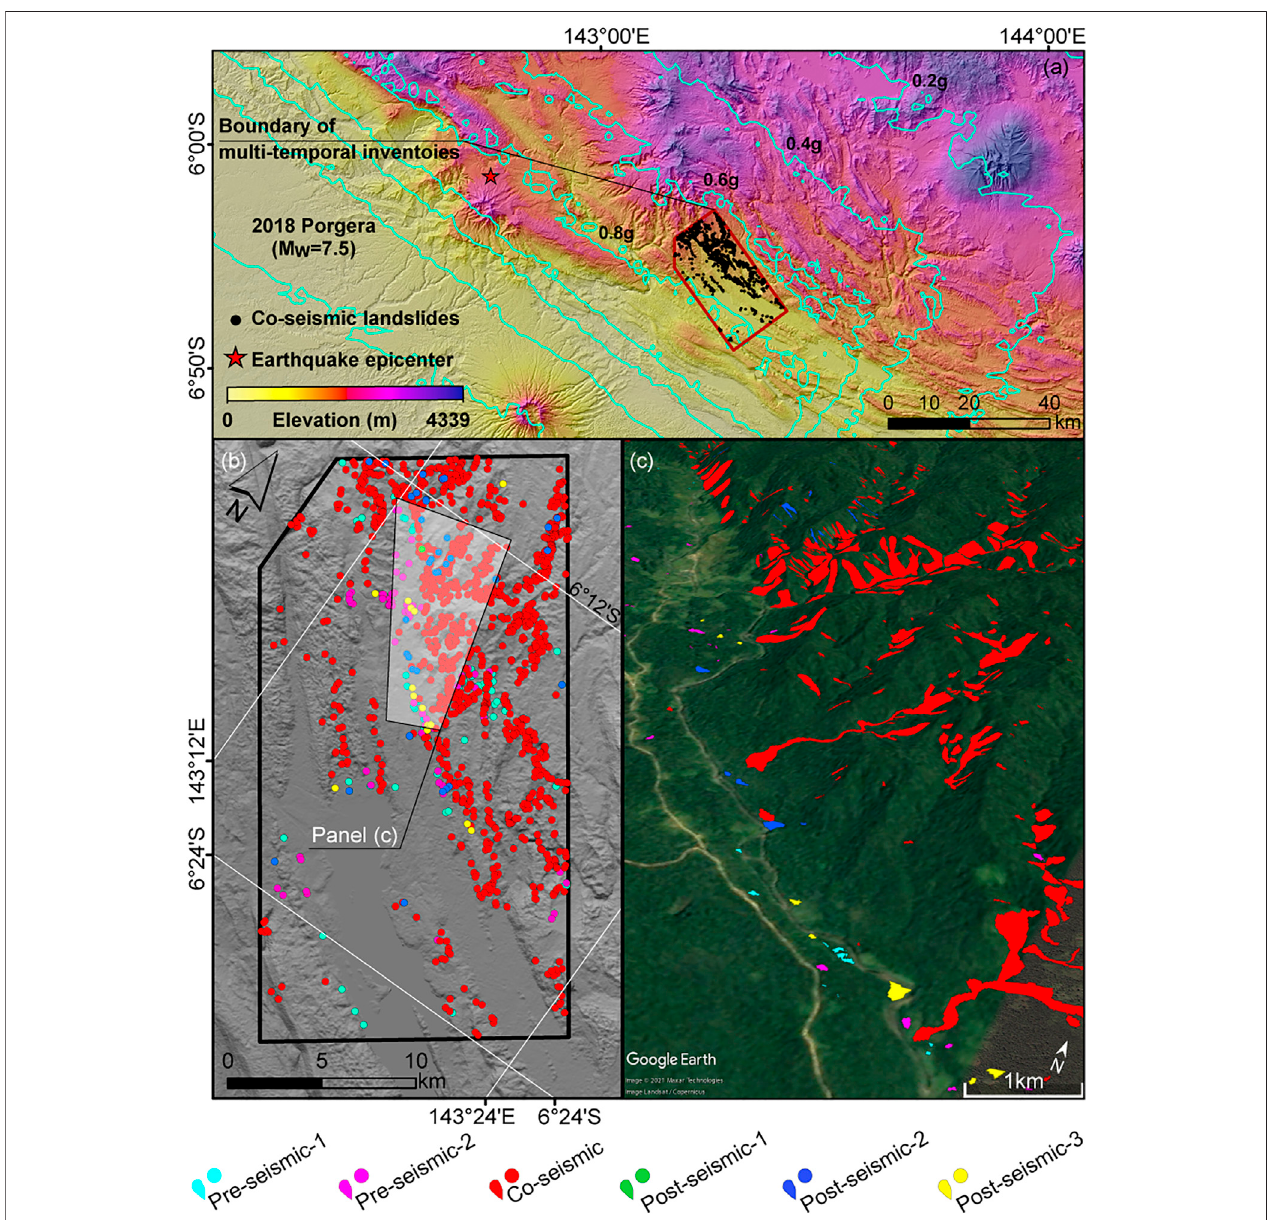
FIGURE3| Mapsshowing (A) arealextentofmulti-temporalinventorieswemappedforthe2018Porgeraearthquake, (B) spatialdistributionofmappedlandslides and (C) Google Earth scene as a sample view of multi-temporal landslide inventories for a subset of the area. In Panel A cyan contour lines show PGA values are acquired from the USGS ShakeMap system (Worden and Wald,